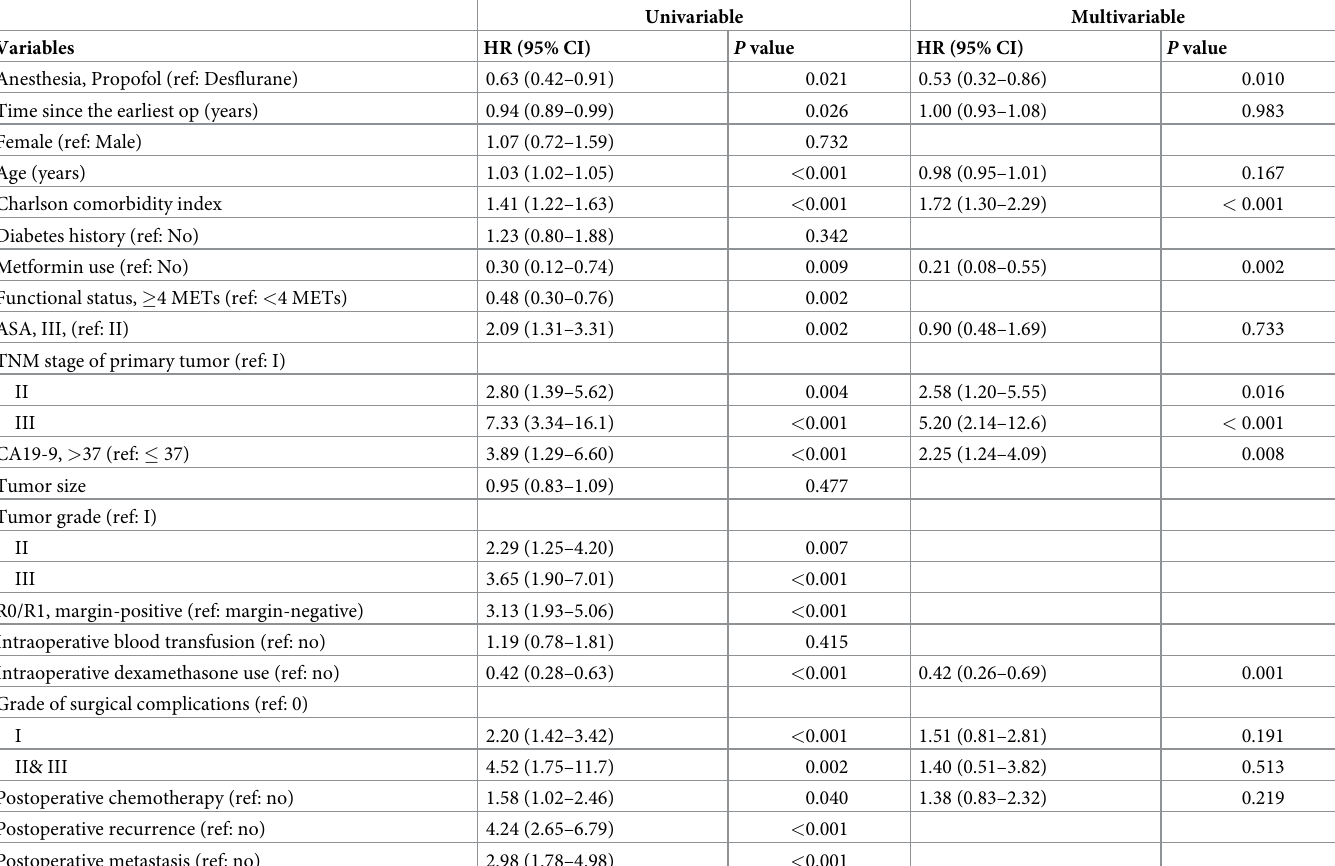
Table 2. Cox proportional hazards regression for mortality: Univariable and multivariable models for overall